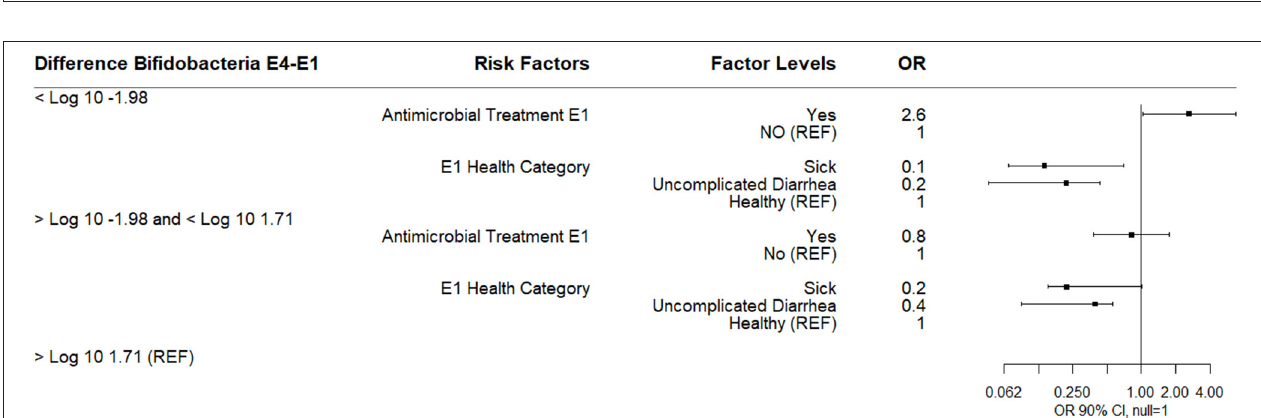
FIGURE 2 | Notched box and whisker plots of change in log 10 Bifidobacterium copies/gram fecal between sampling day E4, E9, E14, and sampling day E1 stratified by antimicrobial treatment group at E1 (no antimicrobial and yes antimicrobial). Points on graph represent values for study calves at each sampling point (E1 = enrollment day and 1st follow-up day, E4 = 4th follow-up day, E9 = 9th follow-up day, and E14 = 14th follow-up day).